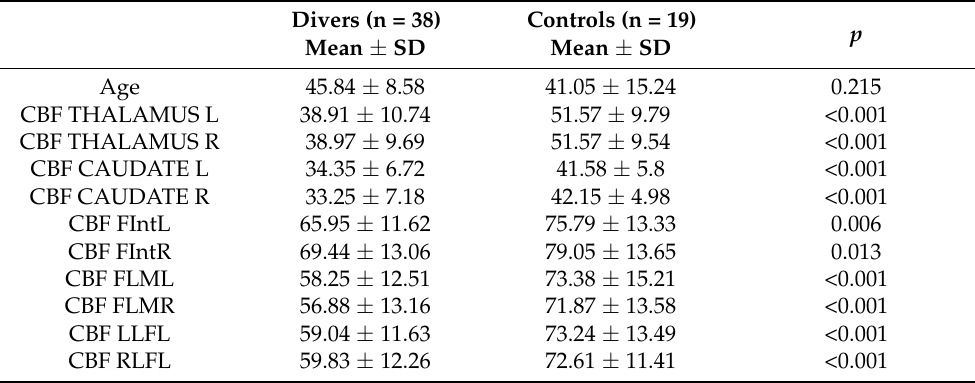
Table 2. Brain blood flow and transit time. Differences between divers and